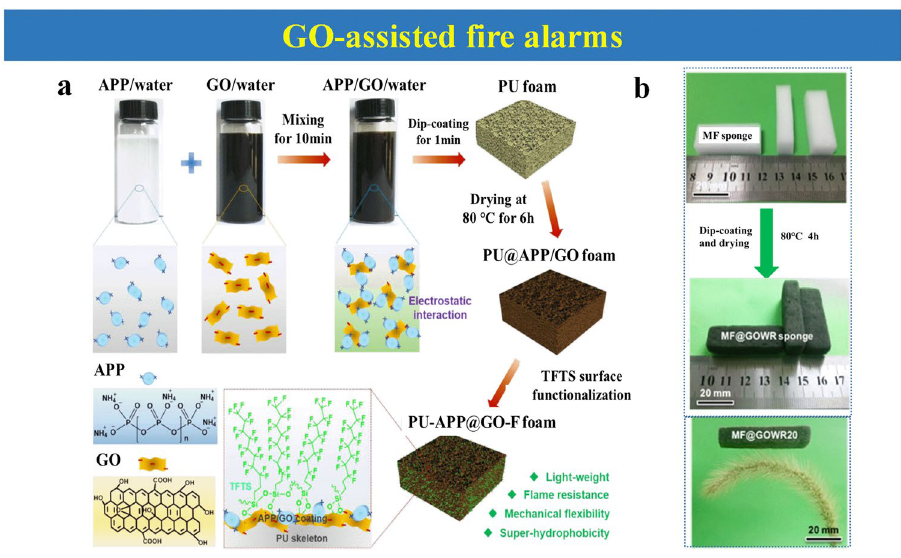
Fig. 7 a Detailed preparation process of water‑based hybrid ammonium polyphosphate (APP) and GO mixture solution coated on the surface of PU foam. Reproduced with permission from Ref. [84]. Copyright 2020 Elsevier. b Pictures of pure MF and MF@GOWR sponges via dip‑ coating way; image of MF@GOWR20 to show lightweight feature. Reproduced with permission from Ref. [18]. Copyright 2019